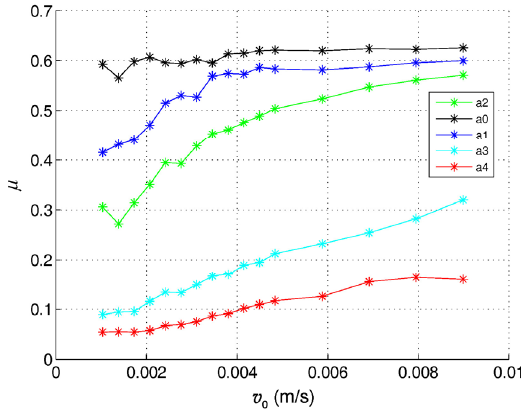
Fig. 9 Experimentally determined dependences of the coefficient of friction on sliding velocity between a steel sphere and a steel disc for increasing amplitudes of out-of-plane oscillation obtained by Milahin (Source: [29], reproduced with permission of the author). The upper-most curve corresponds to sliding in the absence of oscillation. The second, third and fourth curves correspond to amplitudes of 0.06 m u   and z 0.27 m u    z